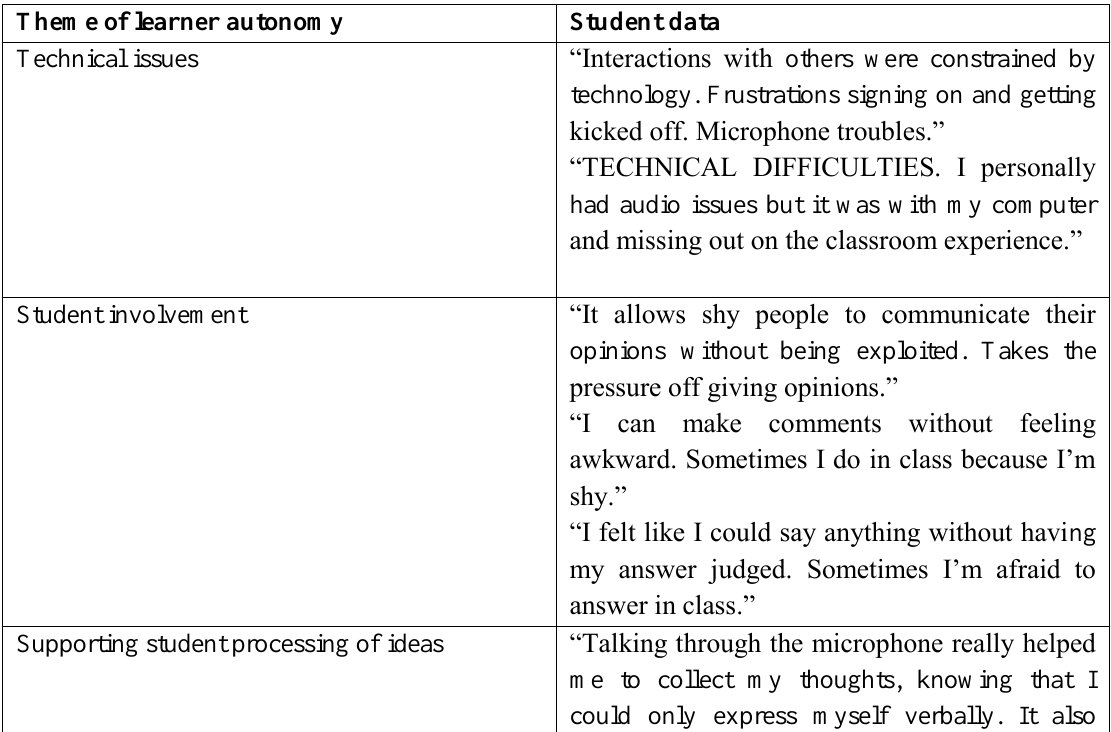
Example of Student Data for Theme of Learner